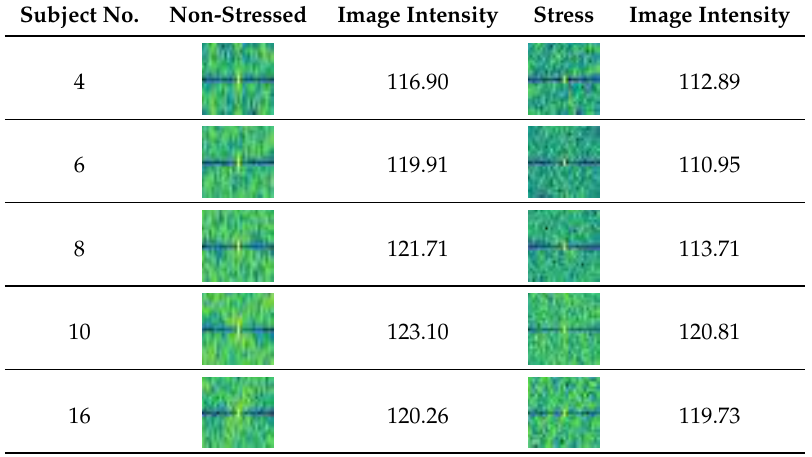
Table 3. The mean of all the pixel values in the entire frequency images (image intensity).